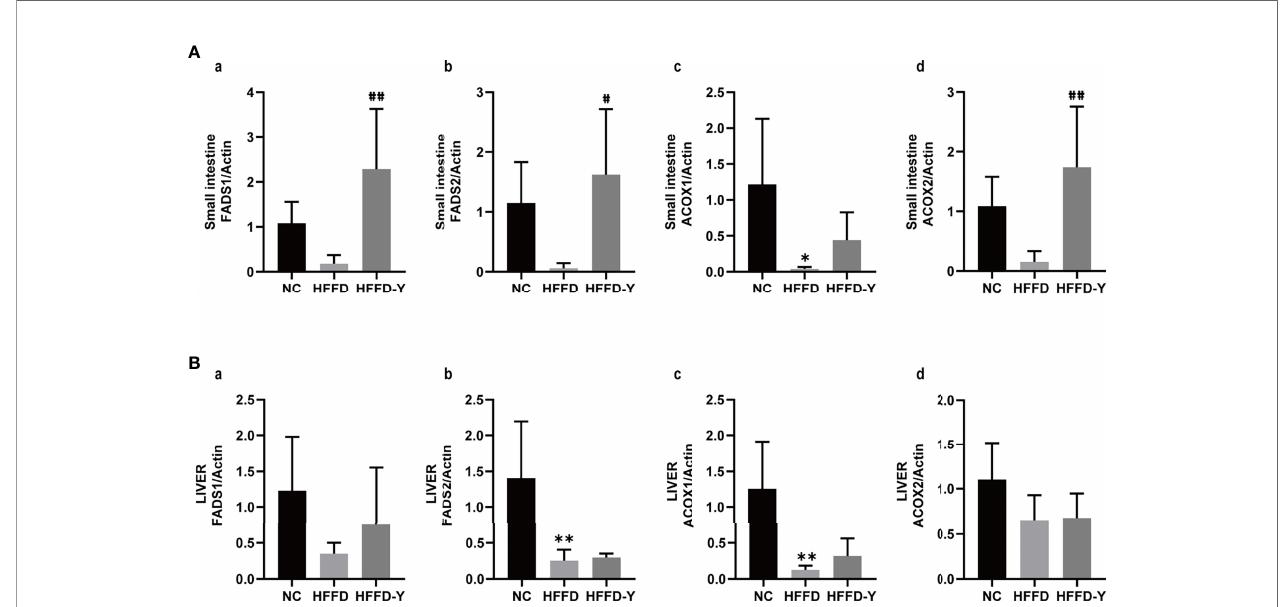
FIGURE 7 | Results of qRT-PCR. (A) RNA expression of ALA metabolism-related hub enzymes in the small intestine of mice. (B) RNA expression of ALA metabolism-related hub enzymes in the liver of mice. (* p <0.05 vs NC, ** p <0.01 vs NC; # p <0.05 vs HFFD, ## p <0.01 vs